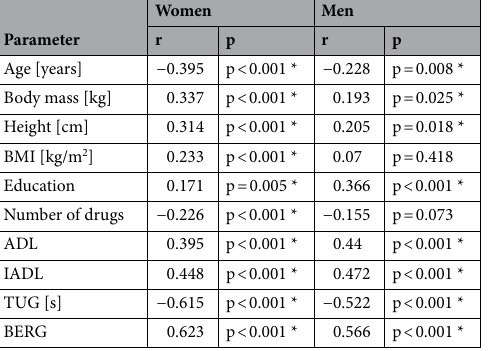
Table 3. Spearman’s rank correlation coefficients between handgrip strength and other variables. BMI: body mass index, ADL: basic activities of daily living, IADL: instrumental activities of daily living, TUG: Timed up and go test, BERG: Berg Balance Test. Notes: * Statistically significant (p <